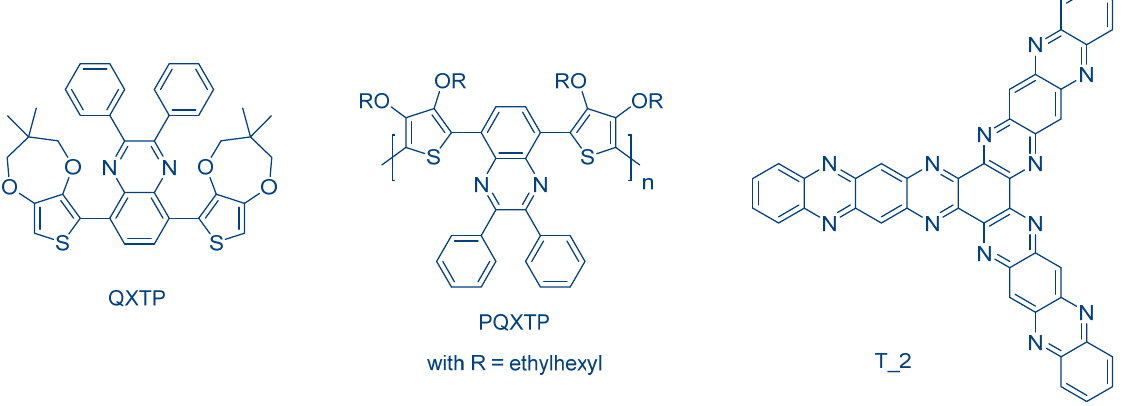
Figure 24. Chemical structures of QXTP, PQXTP and tris (aza)pentacene T_2.